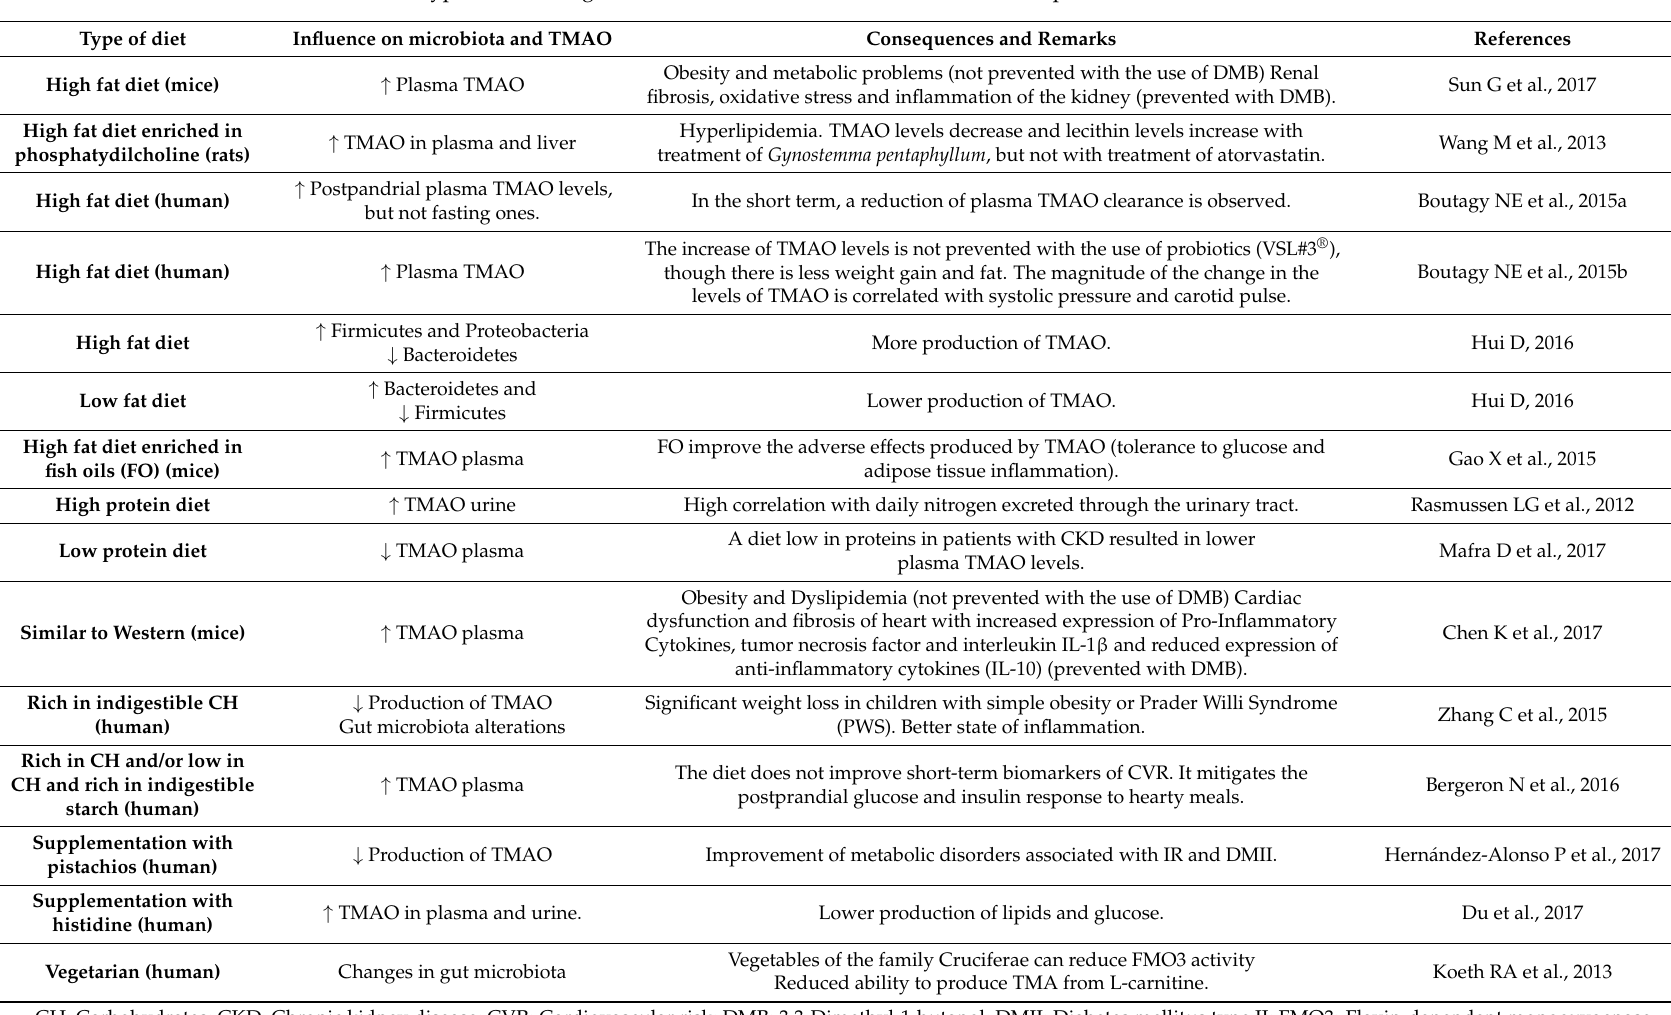
Table 1. Effects of different types of diet on gut microbiota and TMAO levels in different experimental models and metabolic